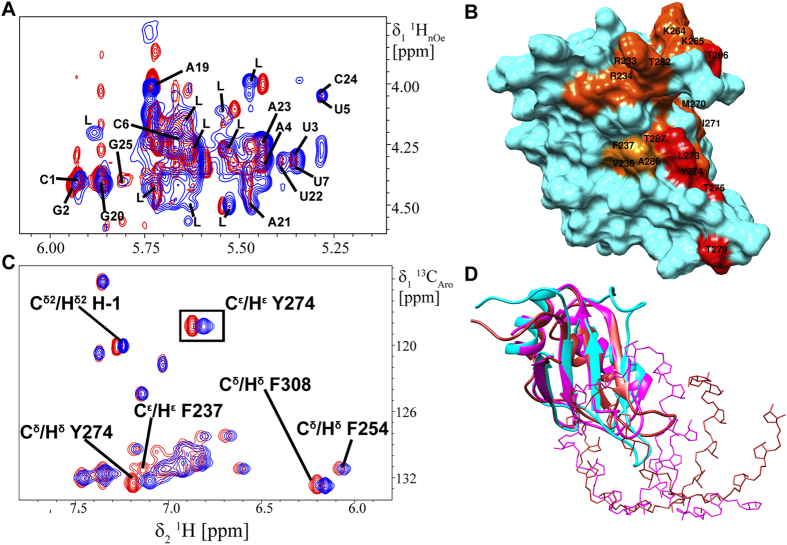
(A) Overlay of 2D [1H,1H] NOESY spectrum of free (red) SON RNA and 2D 13C-[ω1,ω2]-filtered [1H,1H] NOESY (tmix = 350 ms) in D2O at 298 K of U-13C,15N TAF15-RRM with unlabeled RNA (blue) showing changes in intra-ribose H1′-H2′ cross-peaks at 298 K. Peaks arising from the RNA loop are labeled ‘L’. (B) Mapping of CSPs induced by SON stem-loop RNA binding to TAF15-RRM. The color scheme is; orange-red and red for one and two standard deviations from the averaged CSP respectively. (C) Chemical shift changes of Hδ/Cδ and Hε/Cε resonances of Y274, Hε/Cε of F237 and other aromatic residues perturbed to a lesser extent upon RNA binding, shown in an overlay of 2D [13CAro,1HAro] HSQC spectrum of unbound (red) and 1:1.2 bound TAF15-RRM (blue) with SON stem-loop RNA at 298K. (D) Structural alignment of TAF15-RRM (PDB ID 2MMY; cyan) with RBMY (PDB ID: 2FY1; brown) and U1A (PDB ID: 1URN; magenta) stem-loop RNA complexes.